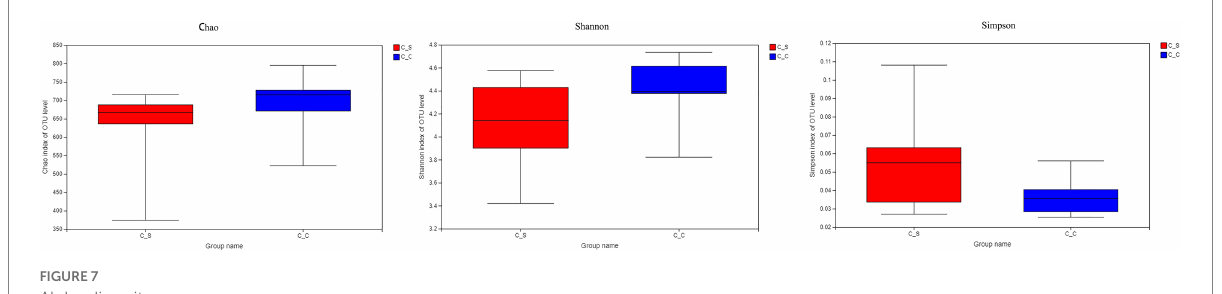
FIGURE 6 Shared OTU across different groups. In the figure, C ▬ S represents the HT group and C ▬ C represents the appropriate temperature group, n =6.